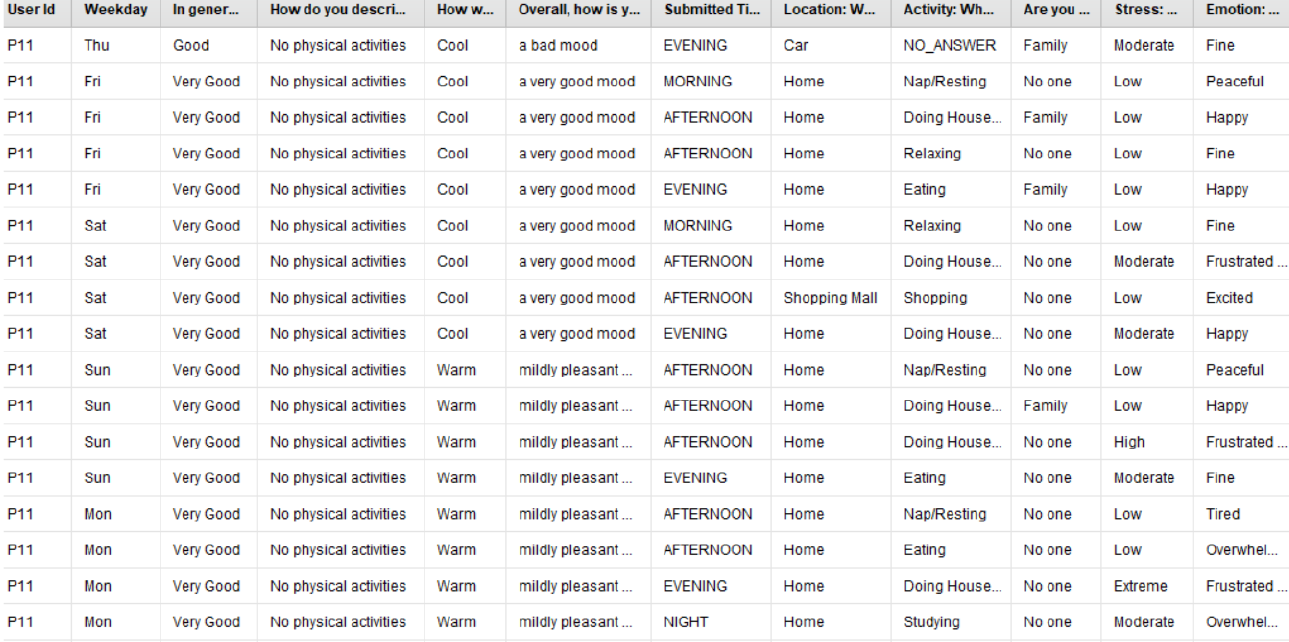
Figure 10. Records of the dataset portraying required fields.